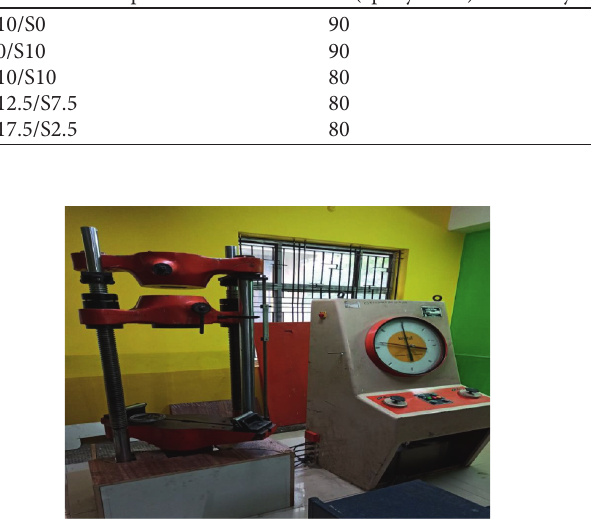
Figure 2: Tensile test machine.